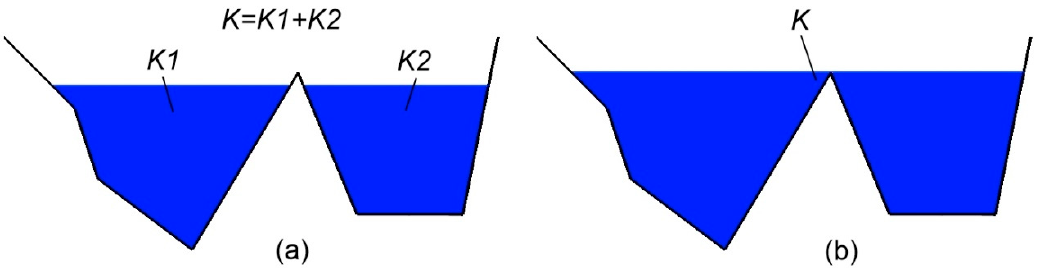
Figure 3. ( a ) Two parallel flows with separate conveyances K 1 and K 2 . Total conveyance K = K 1 + K 2 ; ( b ) flows joined up to a single flow with a single conveyance K